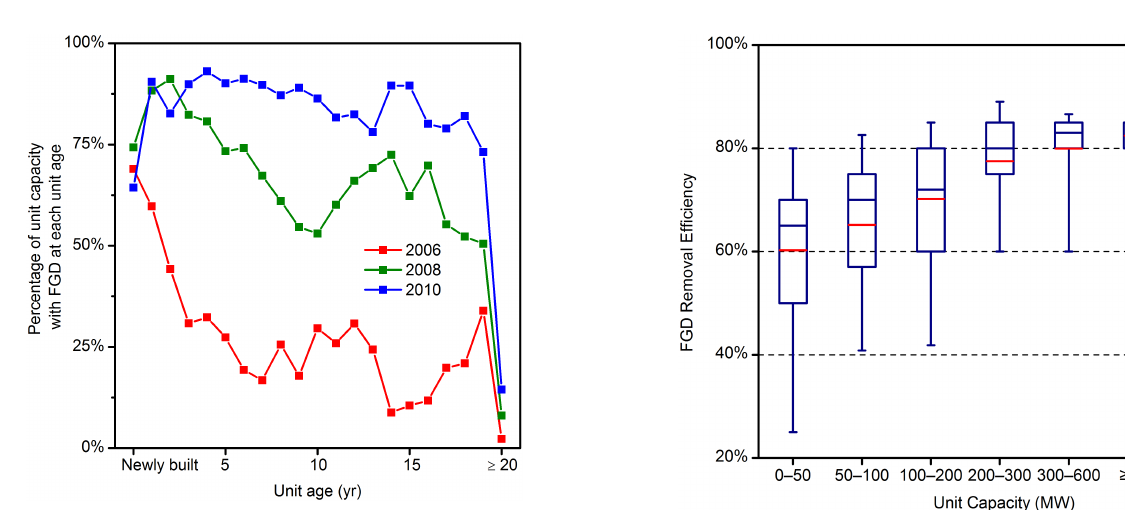
Figure 6. FGD removal efficiencies for electric generating units of various sizes in China in 2010. The blue horizontal line repre- sents the median of the removal efficiencies, the red horizontal line represents the mean removal efficiencies, the box denotes the 25 and 75% percentiles, and the whiskers denote the 5 and 95% per-